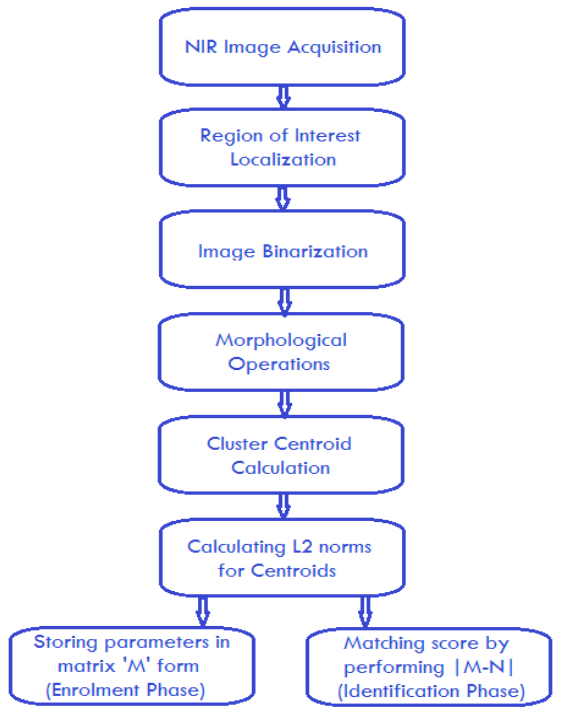
Figure 2. Hand geometry algorithm flow diagram.